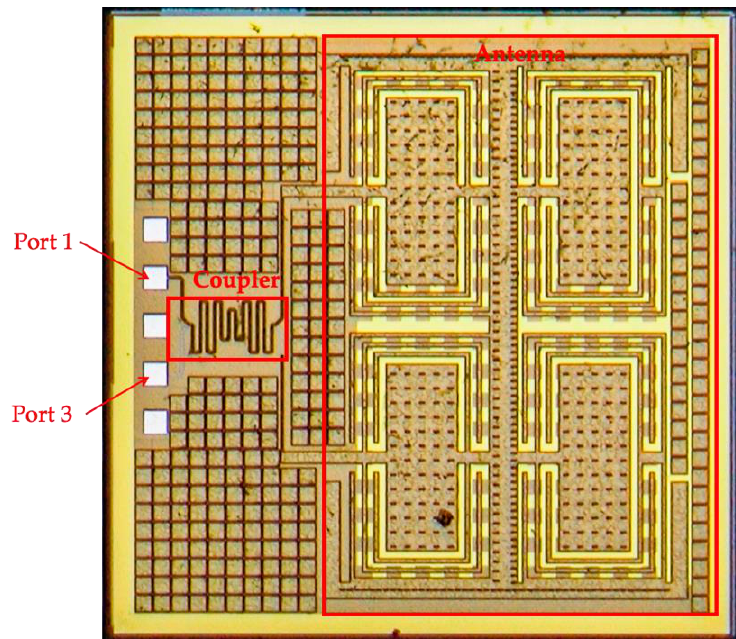
Figure 22. The actual chip. The chip size is 1.2 mm × 1.2 mm .